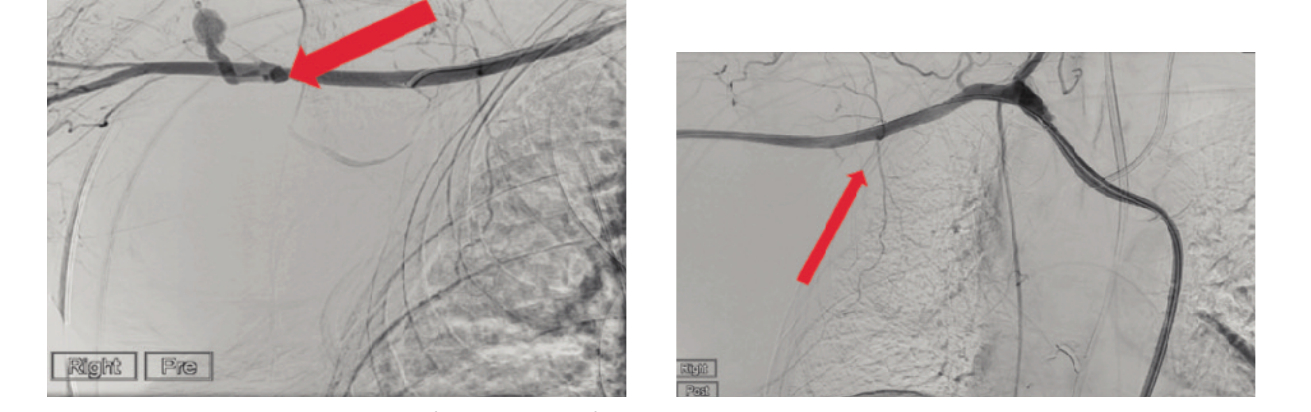
Post-stenting angiogram showing no Fig. 3: